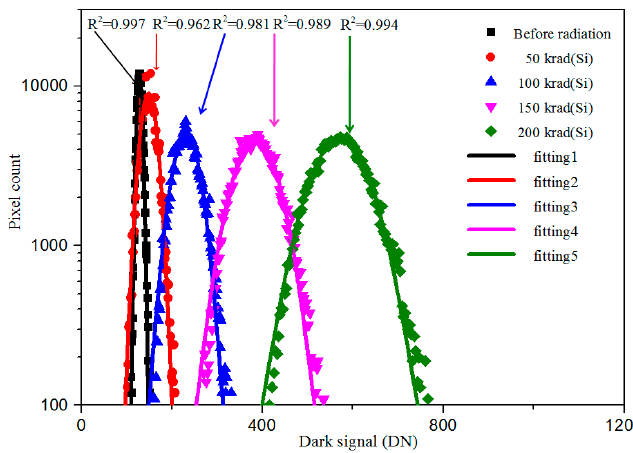
Figure 8. Dark signal distribution of the CIS after gamma radiation.